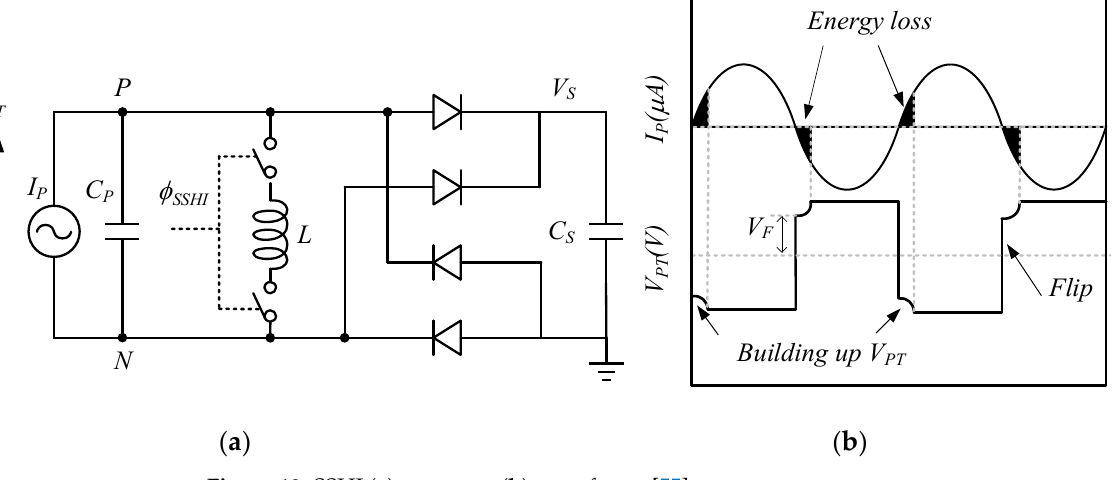
Figure 10. SSHI ( a ) structure, ( b ) waveforms [55].